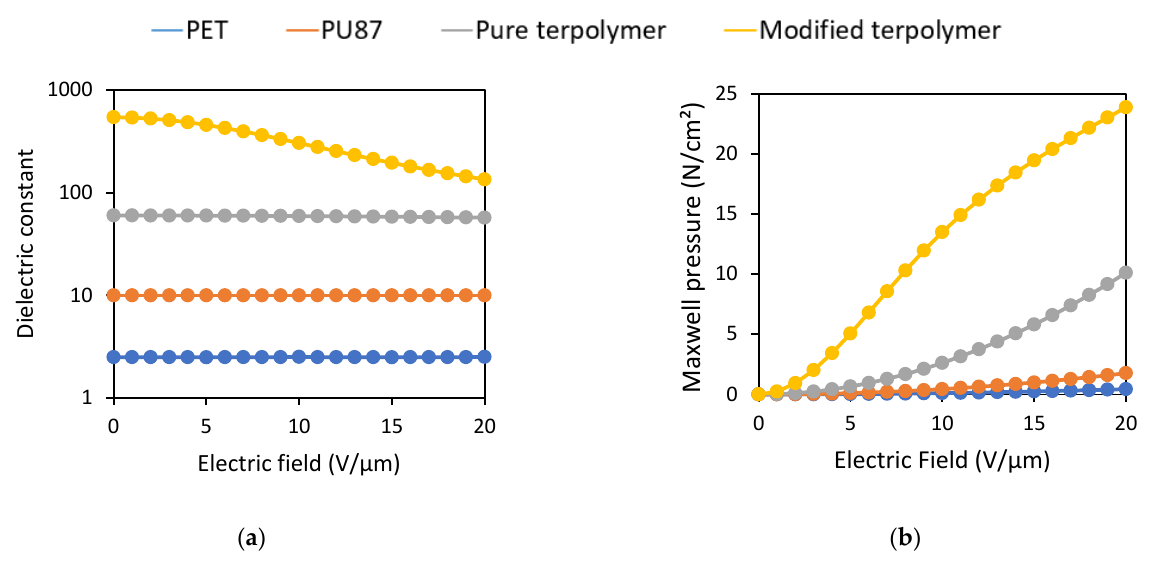
Figure 4. Representation of material performances for electroadhesion: ( a ) Dielectric Constant ( b ) Maxwell